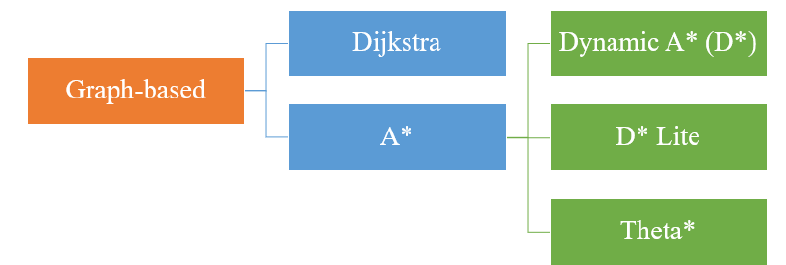
Figure 5. Search